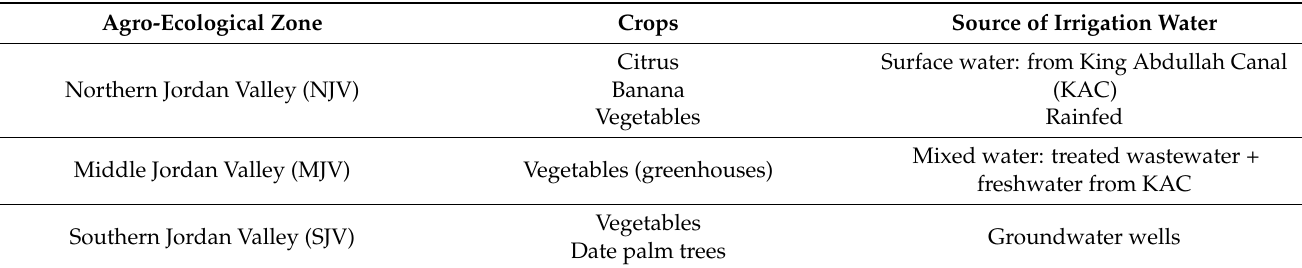
Table 1. Agricultural activities in the Jordan Valley